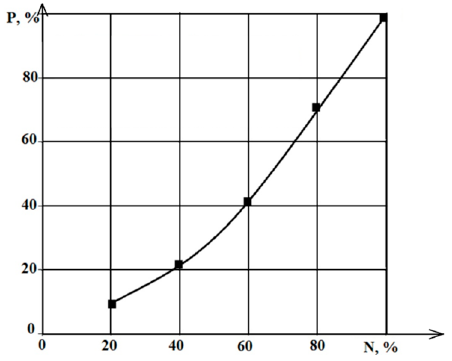
Figure 3. Experimental dependences of the VA signal amplitude on the power output (N) of laser radiation for the effective amplitude (A) of the VA signal in a wide frequency band and the octave band of 16 kHz (A 16 ).